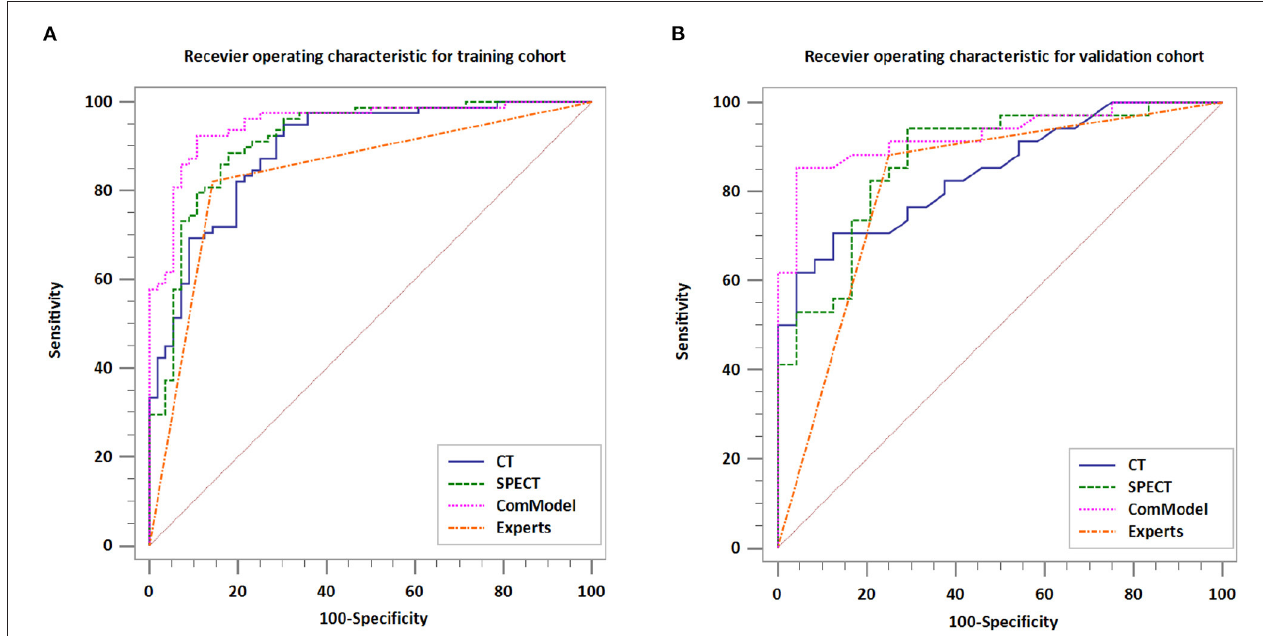
FIGURE 8 | Comparison of the diagnostic performance of different models. (A) Receiver operating characteristic for training cohort. (B) Receiver operating characteristic for validation